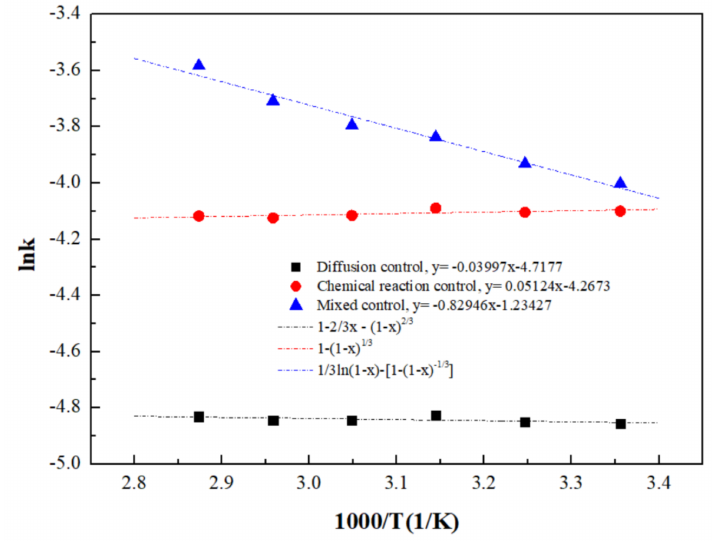
Figure 12. Arrhenius curve obtained for the dissolution of